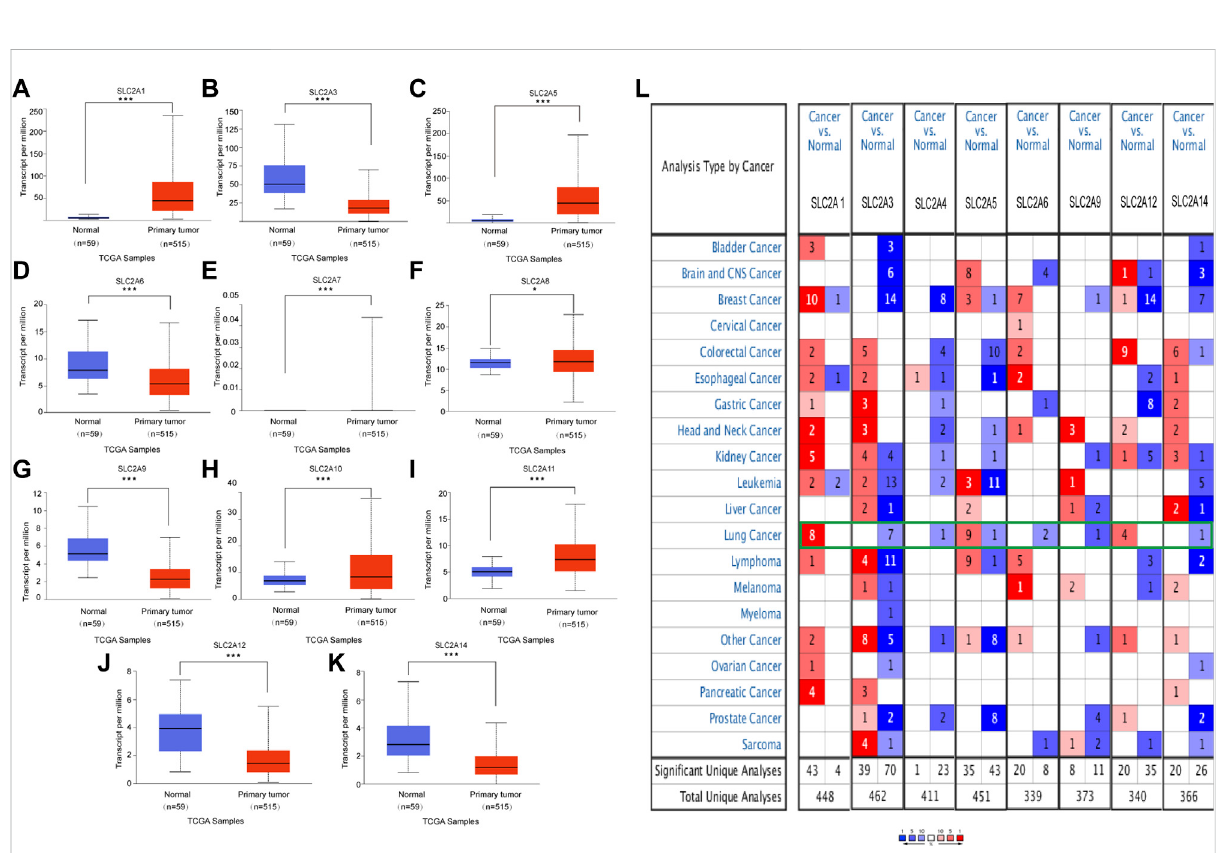
FIGURE 1 mRNA expression of distinct SLC2As in LUAD tissues and adjacent normal lung tissues from UALCAN and ONCOMINE database. (A – K) (UALCAN) mRNA expressions of SLC2A1 , SLC2A5 , SLC2A7 , SLC2A8 , SLC2A10 , SLC2A11 were over-expressed while SLC2A3 , SLC2A6 , SLC2A9 , SLC2A12 , SLC2A14 were downregulated in primary LUAD tissues compared to normal lung tissues. *** p < 0.001, ** < 0.01, * < 0.05. (L) Transcriptional expressionof SLC2As in20differenttypesofcancerdiseases(ONCOMINEdatabase).Differenceoftranscriptionalexpressionwascomparedby Students ’ t -test.Cut-offof p valueandfoldchangewereasfollowing: p